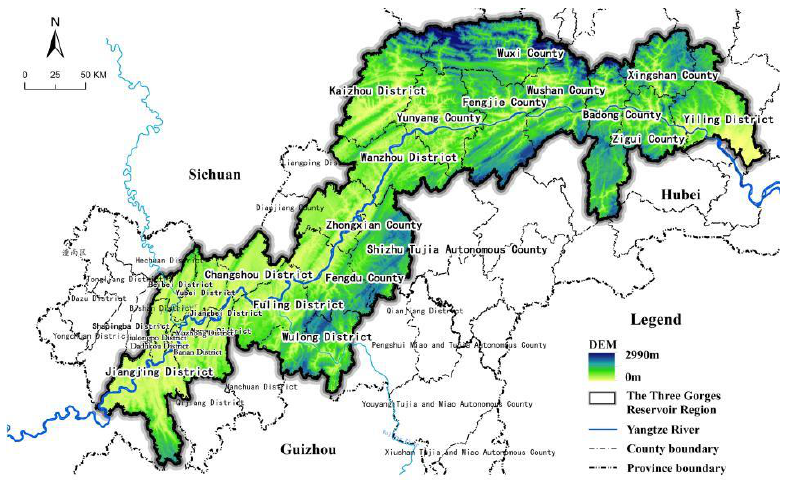
Figure 1. Location of the TGRR.